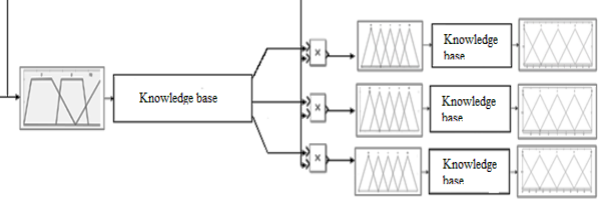
Figure 9. Intelligent controller with spacial membership functions